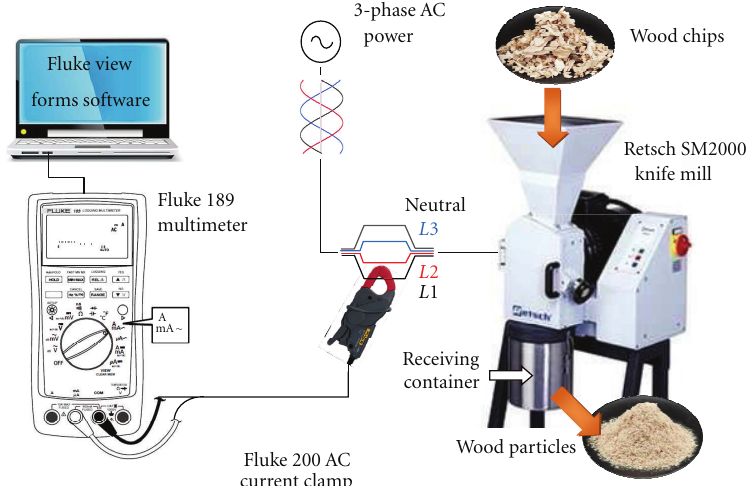
Figure 4: Experimental setup for knife milling of wood chips.